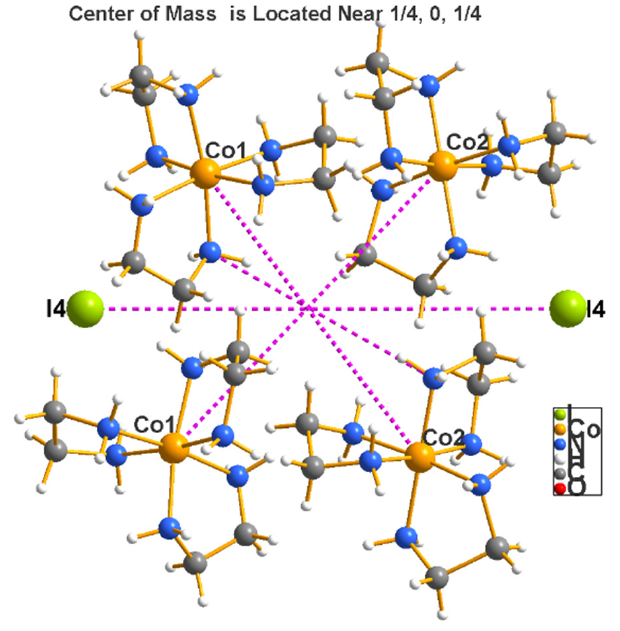
Figure 2. The packing of molecules in (±)-[Co(en) 3 ]I 3 . H 2 O. Because the center of mass is located near but not at ¼, 0, ¼, the Co1 and Co2 pairs are no longer mirror images of each other, e.g., Co1 is Lambda and Co2 is Delta. However, the torsional angles are not identical in magnitude and only some differ in sign. Thus, this is no longer a racemate; instead, it is a kryptoracemic pair. Note that only one fragment of the asymmetric unit, the cobalt cation alone, needs to fail with regard to the presence of the required inversion center or mirror plane. This imperfection constitutes the difference between a racemate and a kryptoracemate.